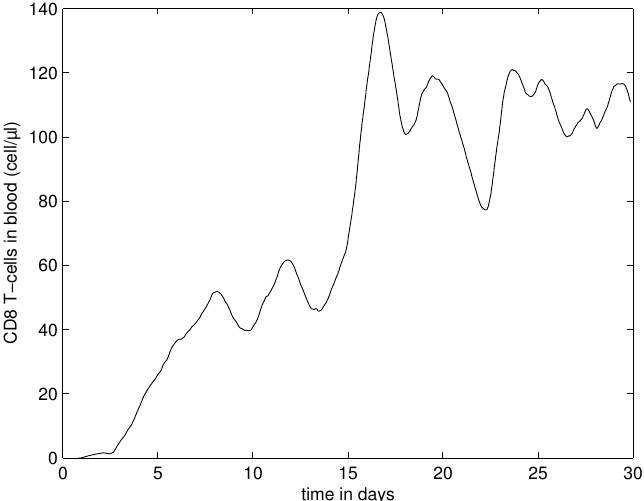
Figure 13. Dynamics of immune response in blood. The population of HIV-specific CD8 + T cells over time (cell/ µ